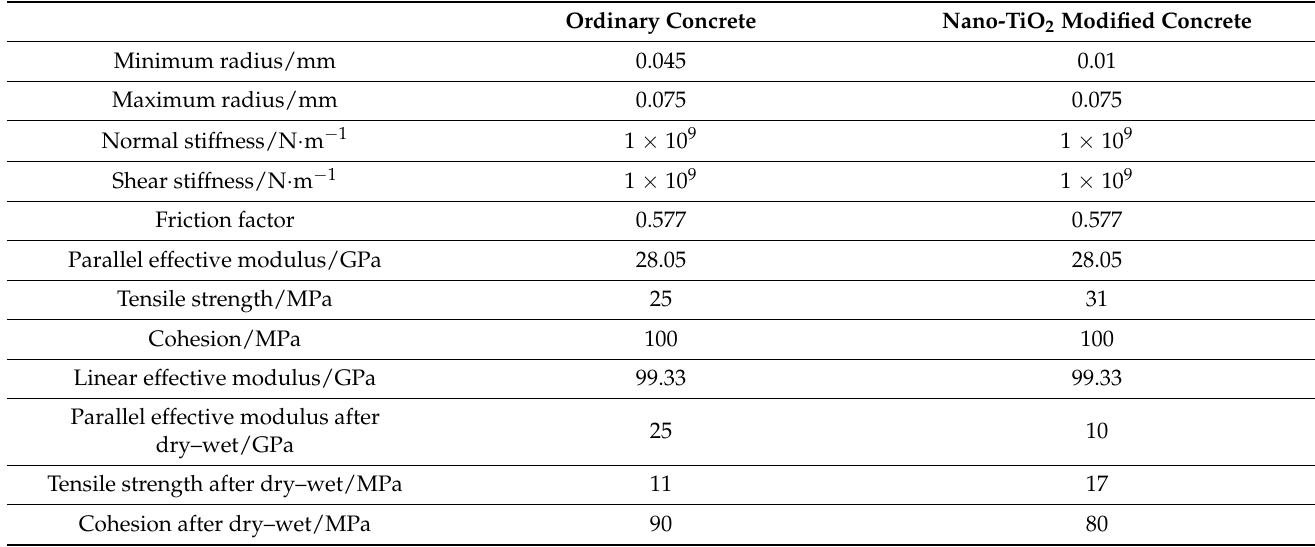
Table 4. Simulation parameters of compression for specimen.